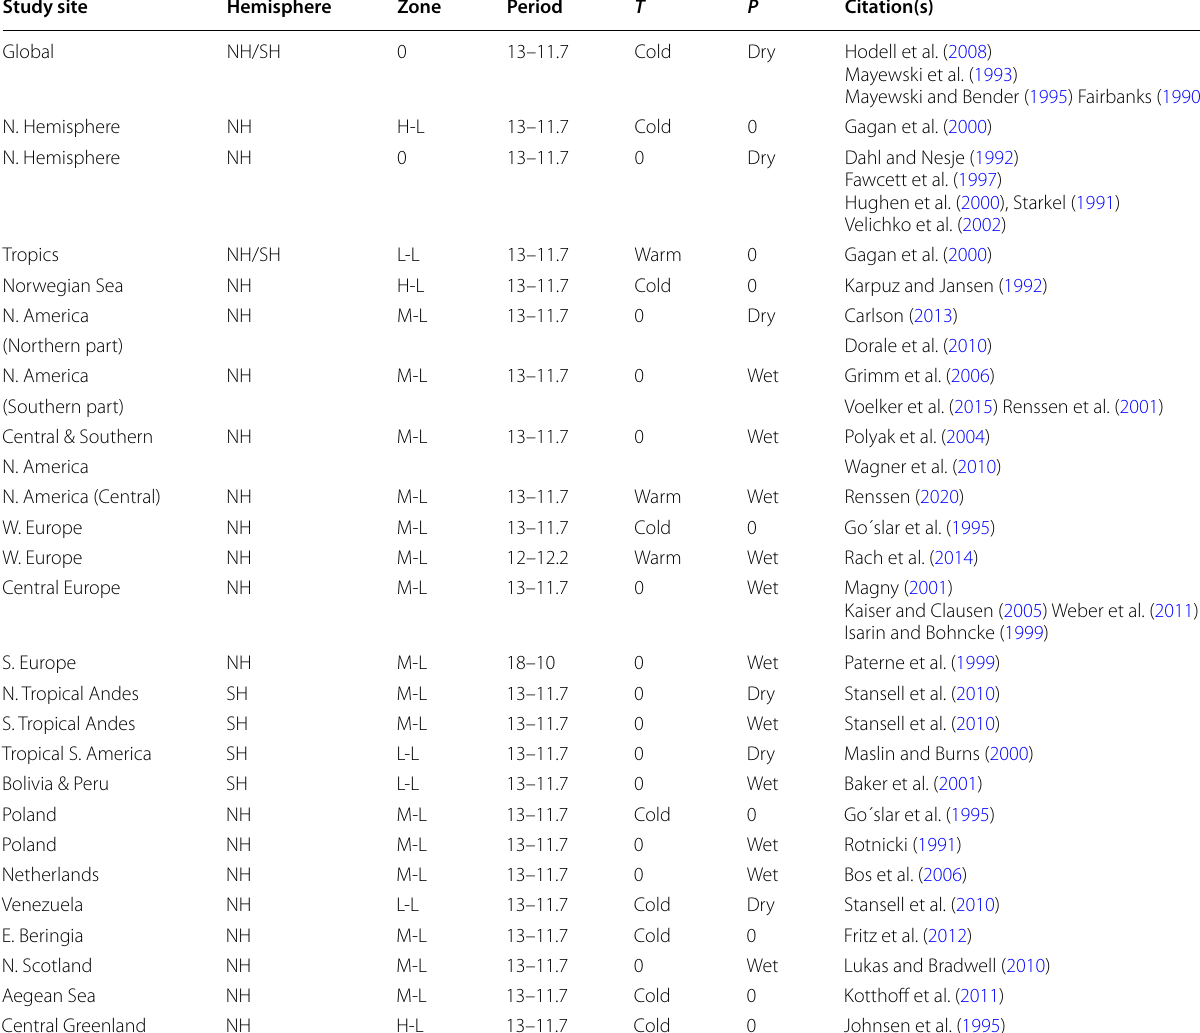
Table 6 Temperature and precipitation conditions during the Younger